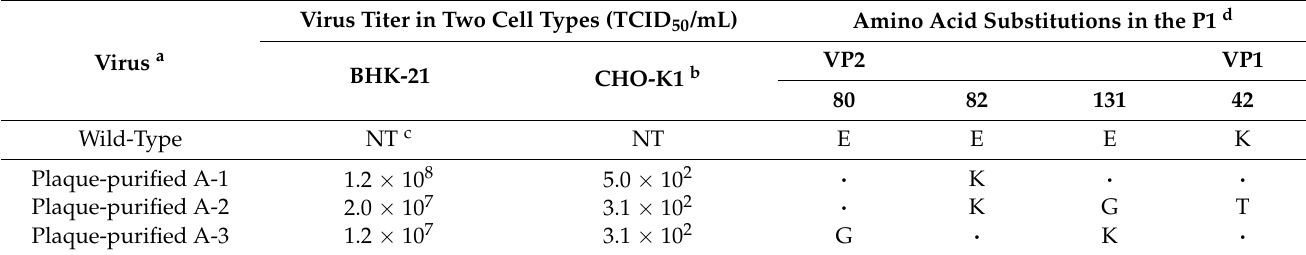
Table 1. Amino acid substitutions in the P1 region in plaque-purified viruses.